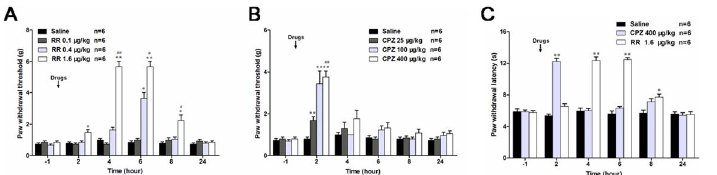
Figure 7. Single intrathecal application of TRPV1 antagonists alleviates mechanical allodynia and thermal hyperalgesia. A and B , single application of RR and CPZ at varing doses caused differential inhibition of mechanical sensitivity of DMA rats. C , single application of RR and CPZ at high dose caused significant inhibition of thermal hyperalgesia in DM rats. * P , 0.05, ** P , 0.01 vs . vehicle control of the same time. # P , 0.05, ## P , 0.01 vs . drugs of middle dose.